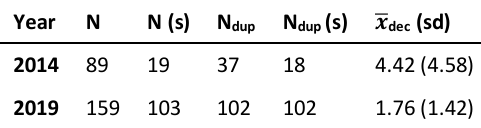
Table 2. Duplicate sightings from visual aerial surveys of narwhals in Northwest Greenland 2014 and 2019. N is total number of sightings, N (s) is the number of sightings made by same side observers within 5 seconds, N dup is the total number of duplicates, N dup (s) is the number of duplicates within 5 seconds